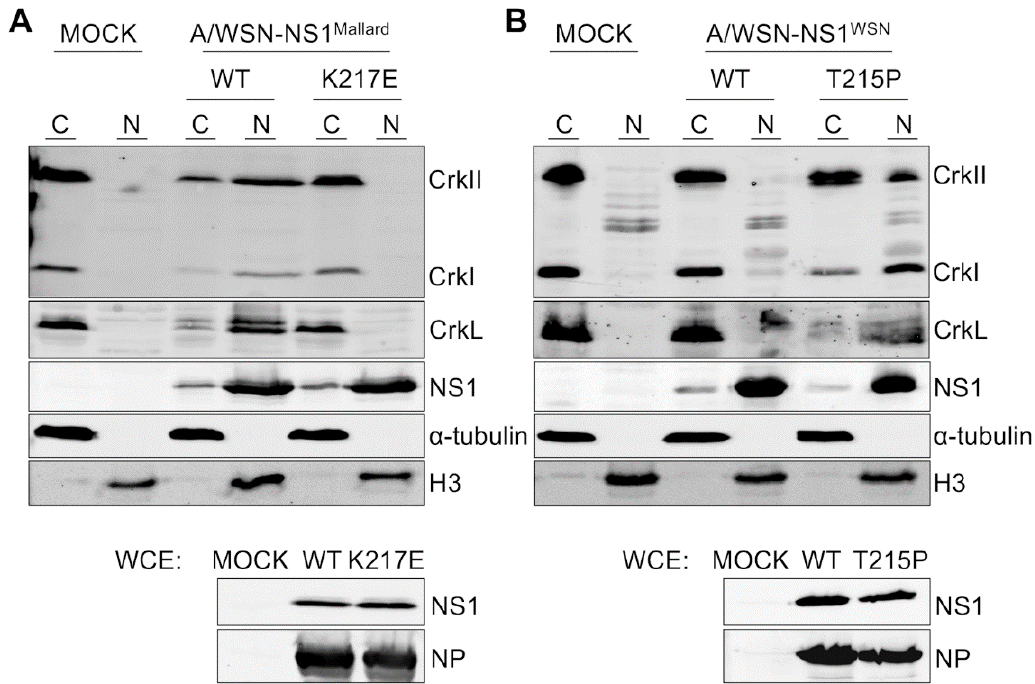
Figure 3. Nuclear translocation of CrkI, CrkII, and CrkL by SH3 binding-competent NS1 proteins demonstrated by subcellular fractionation. ( A ) Western blot analysis of cytoplasmic ( C ) and nuclear extracts ( N ) prepared from A549 cells that were mock-infected ( MOCK ) or infected for 24 h with recombinant A/WSN containing either the wild-type ( WT ) or the K217E mutant NS1 from A/Mallard virus at an MOI 2. In addition to antibodies against the Crk-family proteins and NS1, the blotted A549 fractions were also probed with antibodies against Histone H3 and α -tubulin to confirm successful separation of nuclear and cytoplasmic fractions. In addition, unfractionated whole cell extracts ( WCE ) of the infected cells were Western blotted with anti-NS1 and anti-NP antibodies to confirm uniform infection of cells by the different viruses; ( B ) Same as ( A ) except that the cells were infected with recombinant A/WSN virus carrying wild-type ( WT ) or the T215P mutant NS1 from A/WSN.